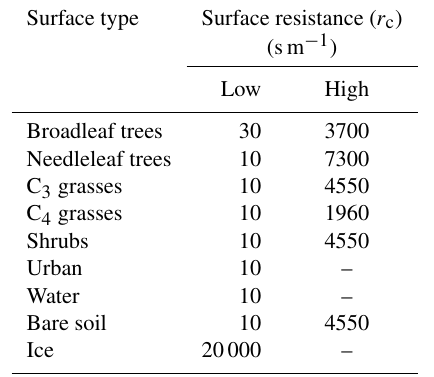
Table 2. Surface resistances for SOA precursors over the nine dif- ferent surface types in the model. “Low” represents surface resis- tances of ROOH, which are taken field studies (Hall et al., 1999; Nguyen et al., 2015). “High” represents surface resistances of